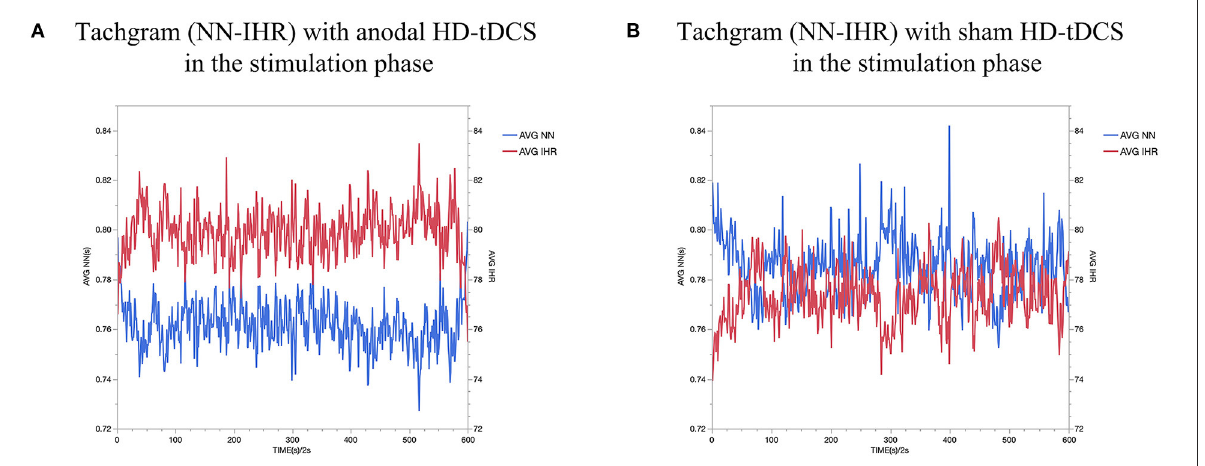
FIGURE5 AVG NN interval and AVG IHR comparing Anodal HD-tDCS (A) vs sham HD-tDCS (B) . The red dash represents AVG IHR and the blue dash represents AVG NN.